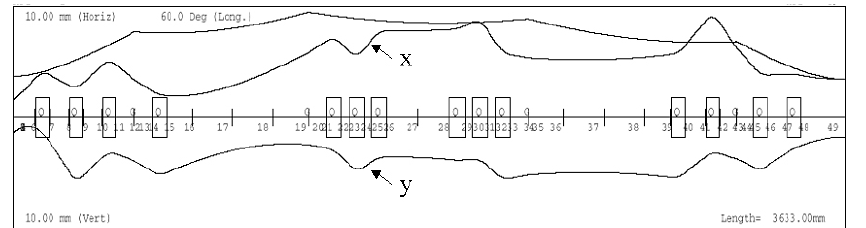
FIG. 12. Trace 3D beam envelope profiles of the modified MEBT optics yielding a more circular cross section in the antichopper.